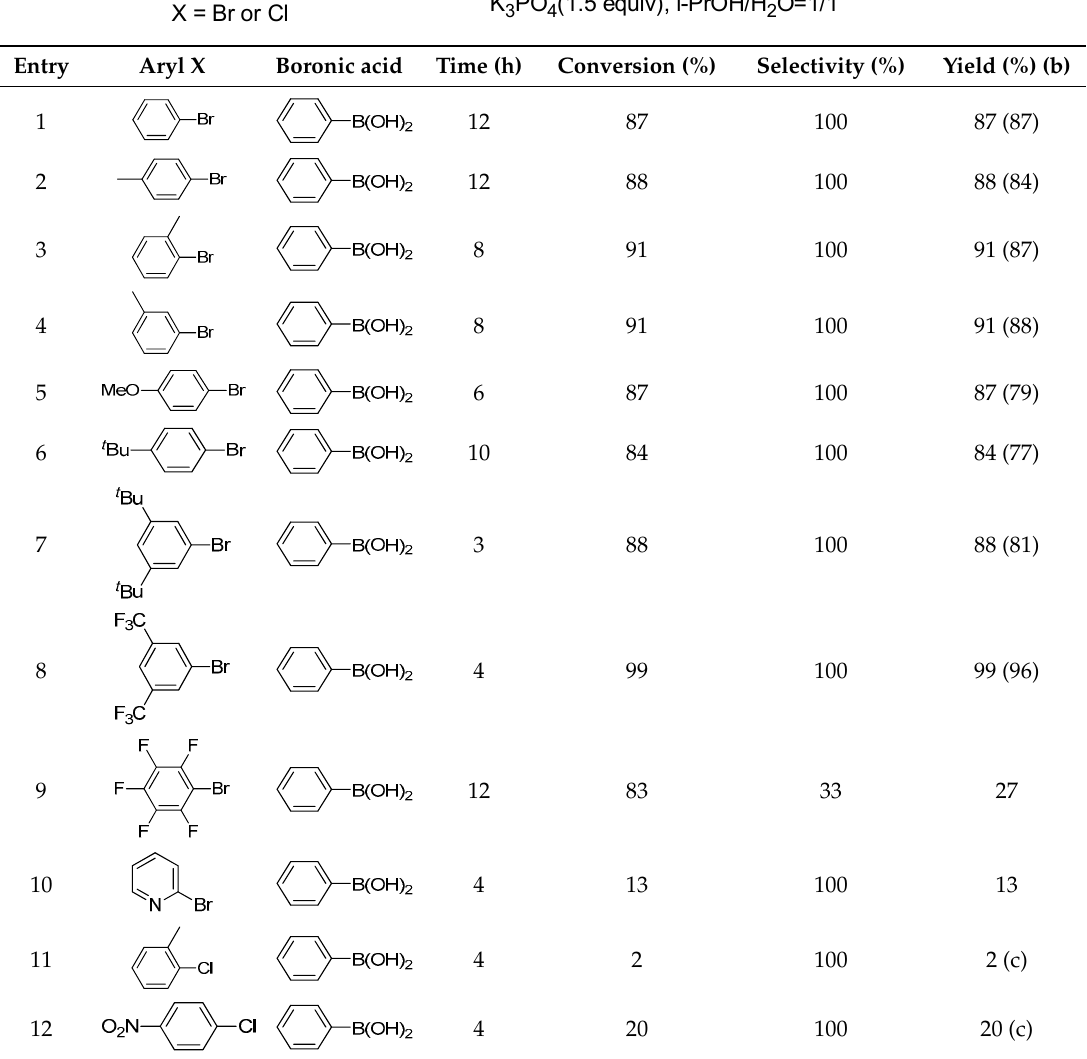
Table 3. Suzuki coupling reactions of various aryl halides (X) and phenylboronic acid over Pd ‐ diimine@SBA ‐ 15catalyst (a).